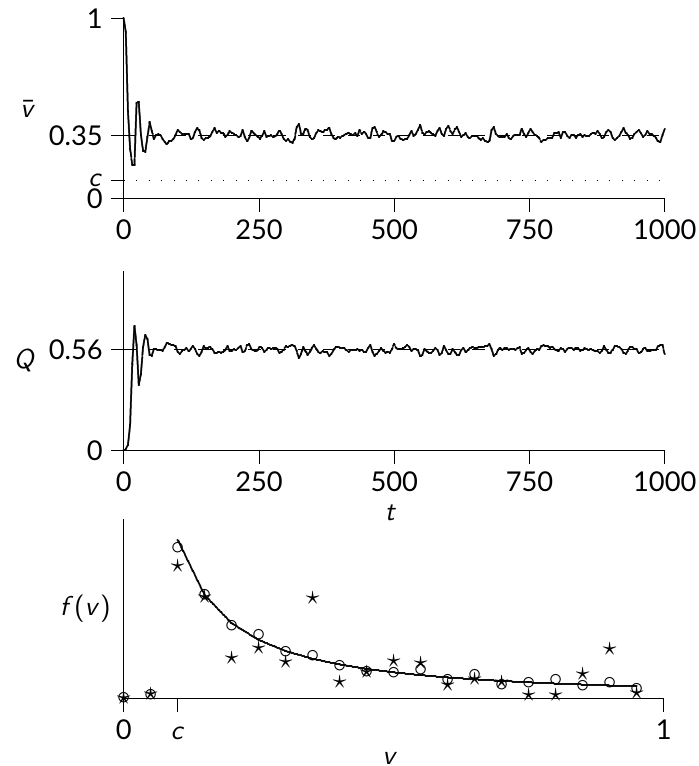
Figure 5 – Stable dynamics in a simulation with pure strategies, assuming c = 0.1 , K = 4 , K c = 1.6 K c > 1 and 2 . In this simulation, 2 , so the NE resists invasion by pure strategies. In the lower panels of these figures, the stars and circles represent empirical frequency distri- butions of the strategy variable v . The stars show distributions calculated from each simulation’s final generation, while the circles show a distribution averaged over many generations. The solid line shows the predicted frequencies at the NE, as calculated from equation 10. The starred distri- bution fits the NE poorly in figure 4 but fairly well in figure 5. The long term average distribution (shown by circles) fits the NE well in both